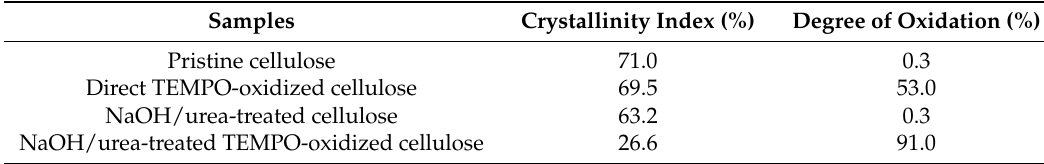
Table 1. Crystallinity index and degree of oxidation of cellulose before and after oxidation. Samples Crystallinity Index (%) Degree of Oxidation (%) Pristine cellulose 71.0 0.3 Direct TEMPO-oxidized cellulose 69.5 53.0 NaOH/urea-treated cellulose 63.2 0.3 NaOH/urea-treated TEMPO-oxidized cellulose